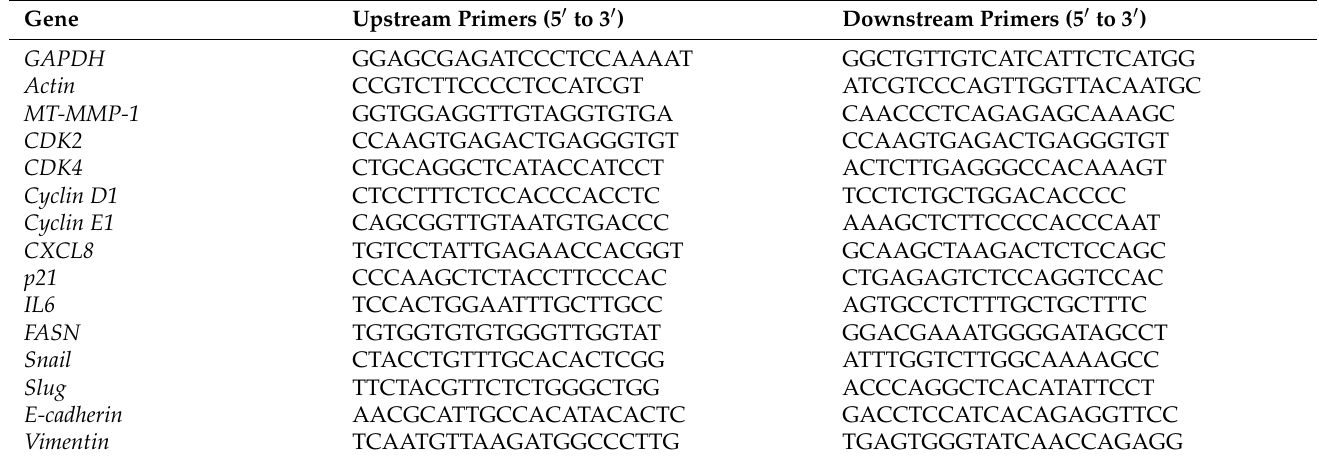
Table 3. The design of